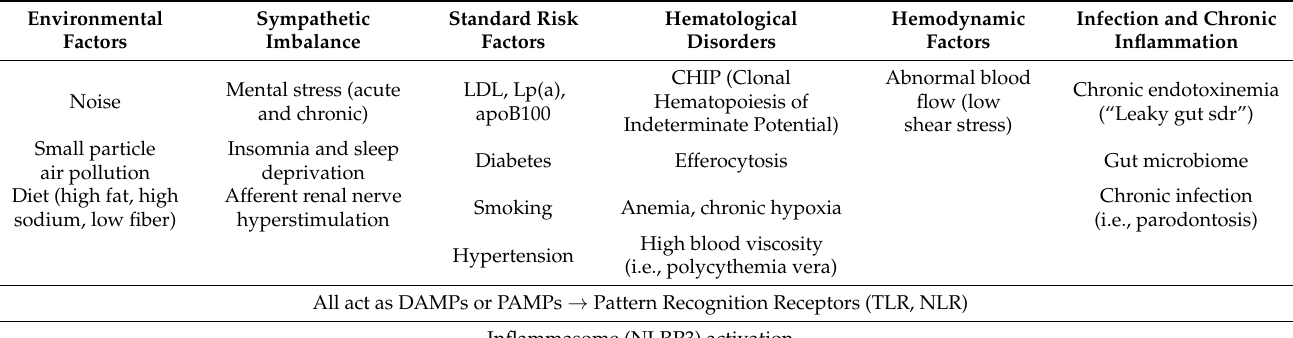
Table 1. External or endogenous factors may act as DAMPs or PAMPs to stimulate membrane (TLRs) or cytoplasmic receptors NLRs) of monocytes, macrophages, neutrophils or dendritic cells. They may trigger inflammasome oligomerization and activate NLRP3 macromolecule.